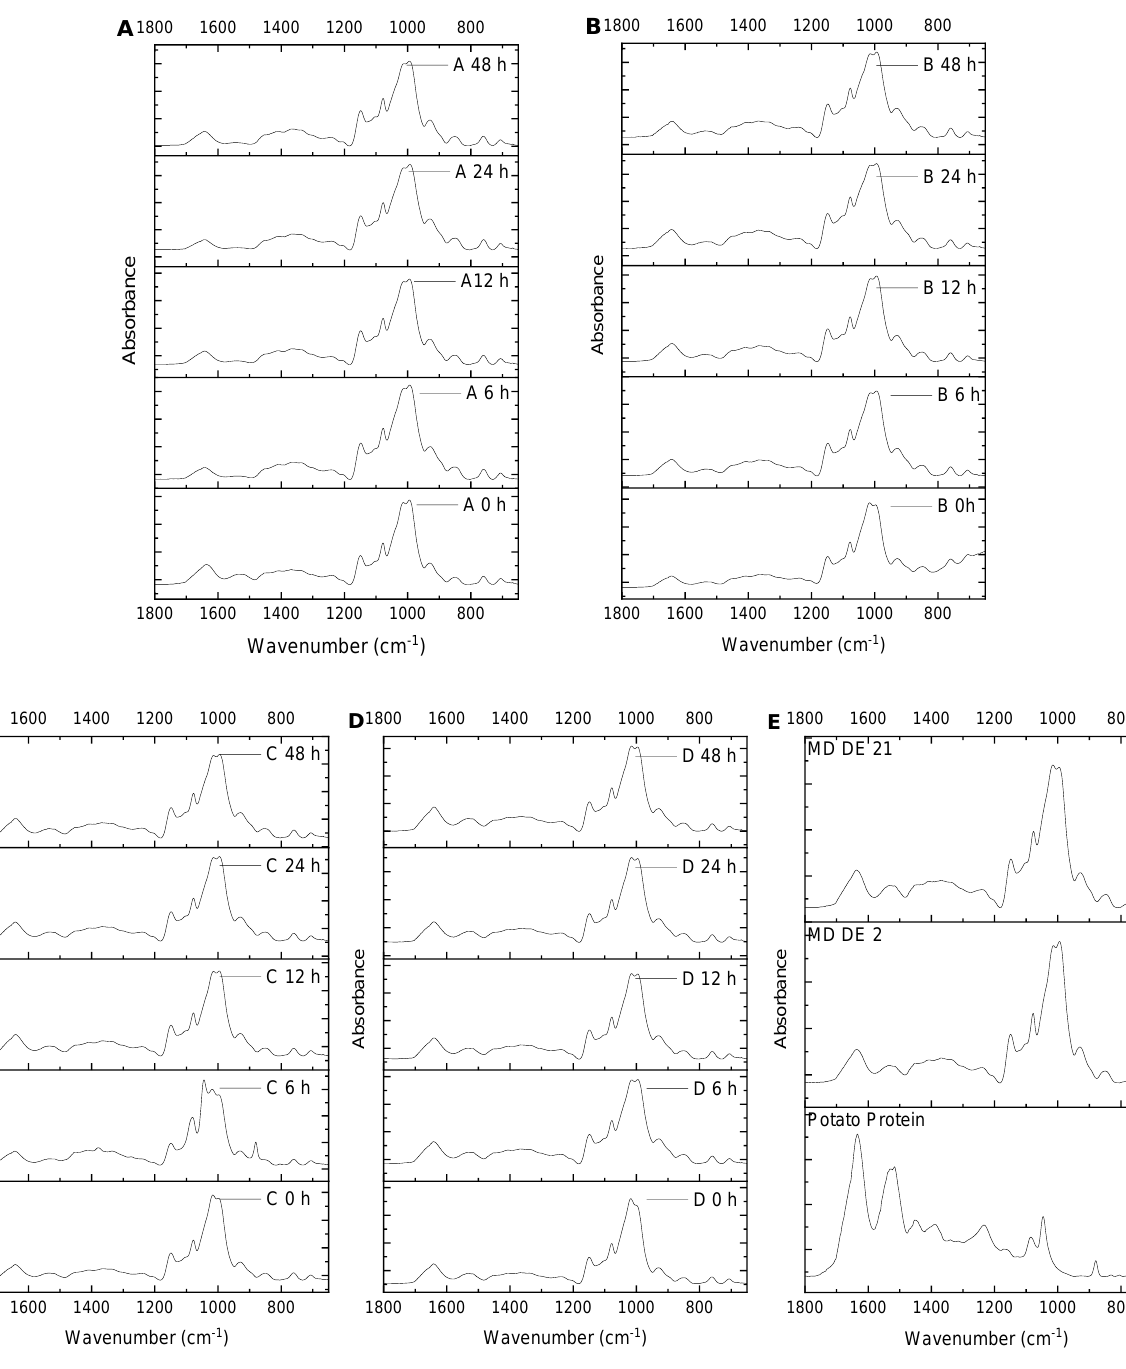
Figure 3. FTIR spectra (700 − 1800 cm − 1 ) of all fibers with different ratios (MD DE 2:MD DE 21:PP)— ( A ) (80:10:5), ( B ) (80:10:10), ( C ) (80:10:15), ( D ) (80:10:20), and ( E ) maltodextrins DE 21, DE 2, and potato protein.